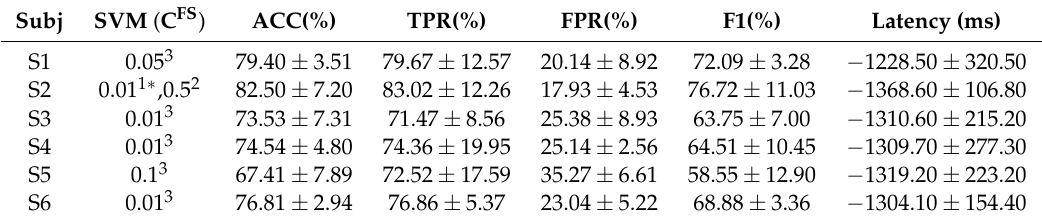
Table 1. Performance of the BCI based on Ad WAR to recognize gait planning.